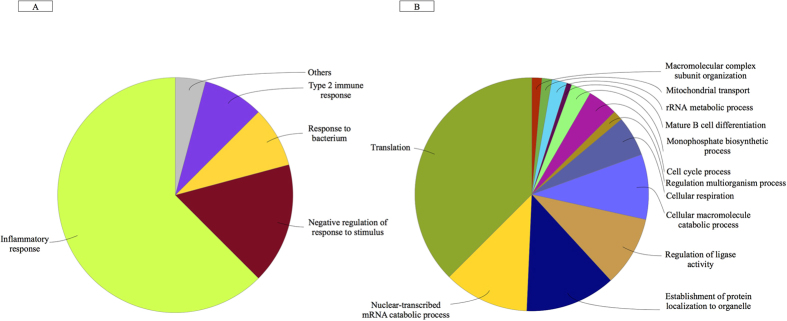
A functional map of DEGs, showing the top categories of GO biological processes associated with significantly over-expressed (A) and under-expressed (B) genes following endurance exercise. The chart fragments represent the number of genes associated with the various terms.